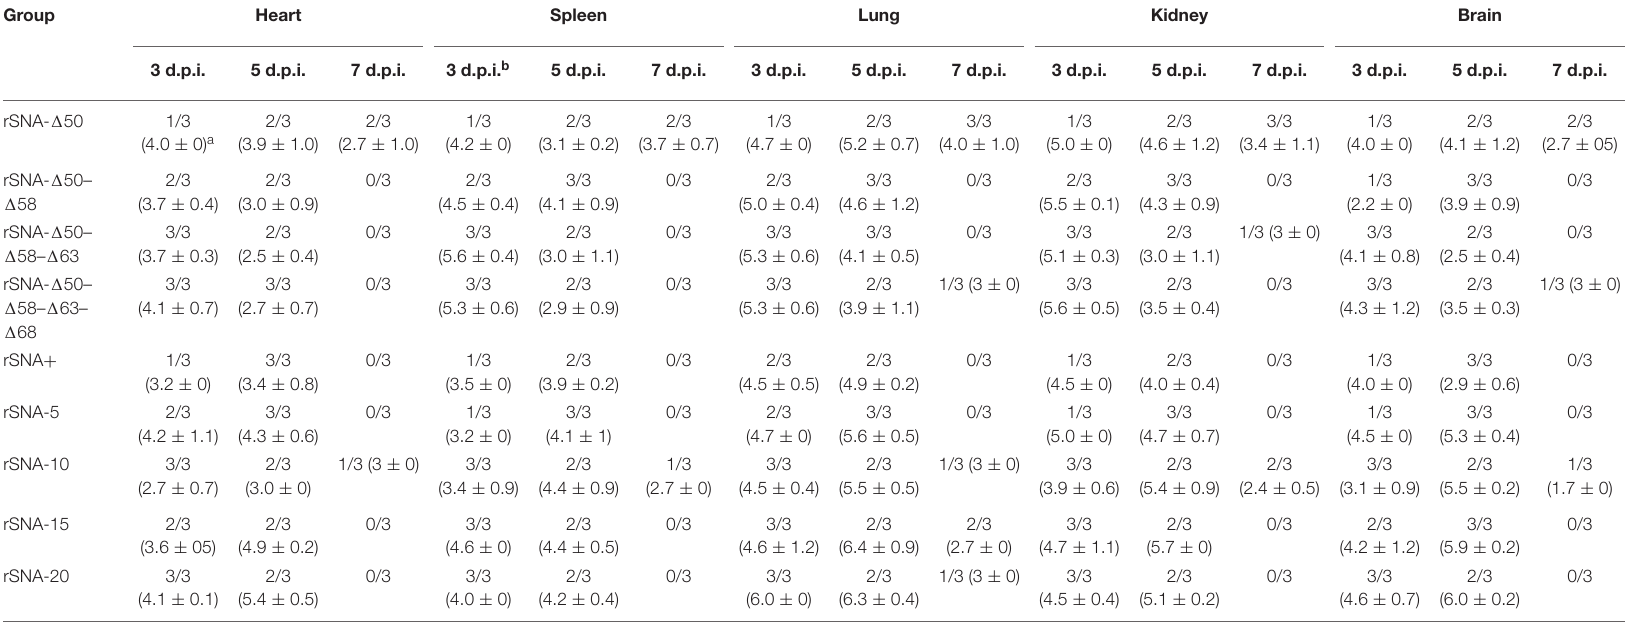
TABLE 4 | Replication of recombinant viruses in the experimentally infected mallard ducks. Group Heart Spleen Lung Kidney